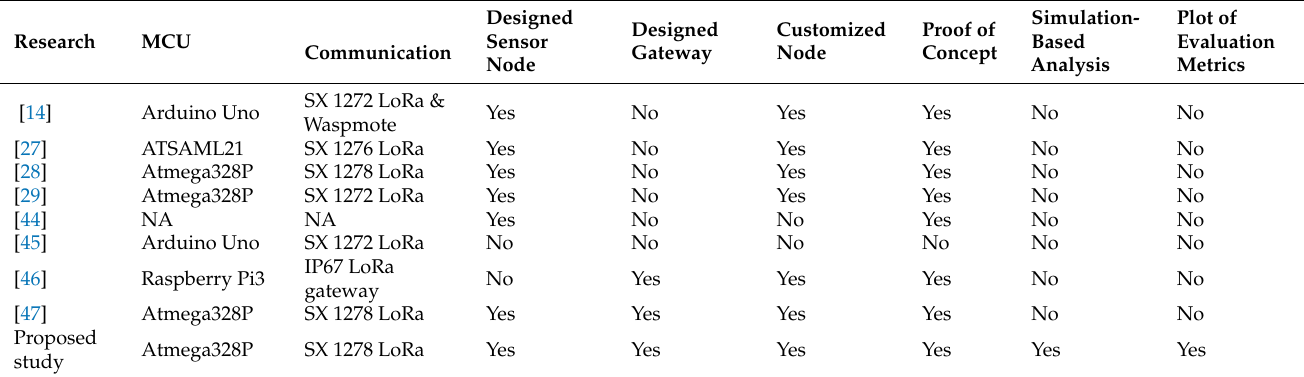
Table 12. Comparison of our study with previous studies.